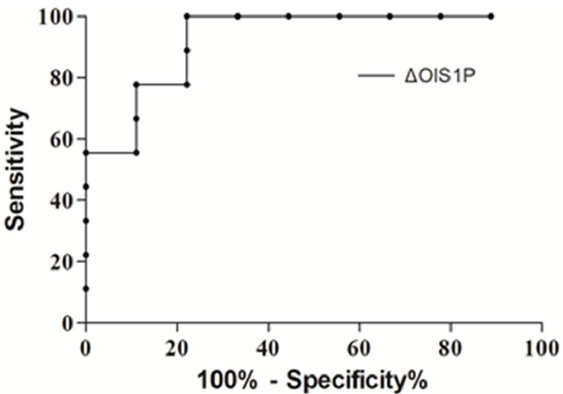
Figure 3. Receiver operator curve for the change in the Oxygenation Index from baseline semi re- cumbent (SR BAS ) to 18hour prone ( ΔΟΙ S18hP ) and the change in the Oxygenation Index from baseline semi recumbent (SR BAS ) to 1 h prone ( ΔΟΙ S1hP ).